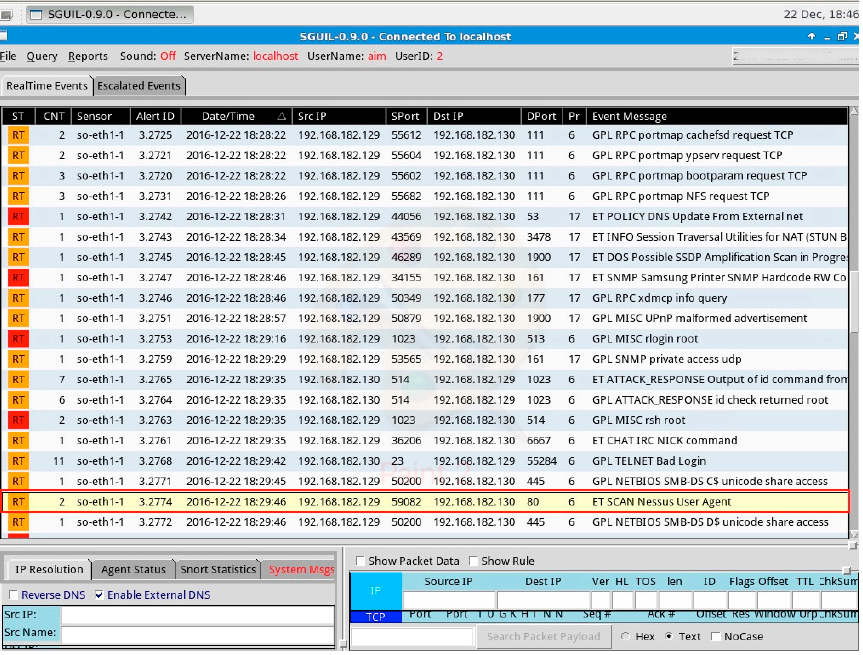
Figure 7. Sguil Output: Nessus Vulnerability Scan.